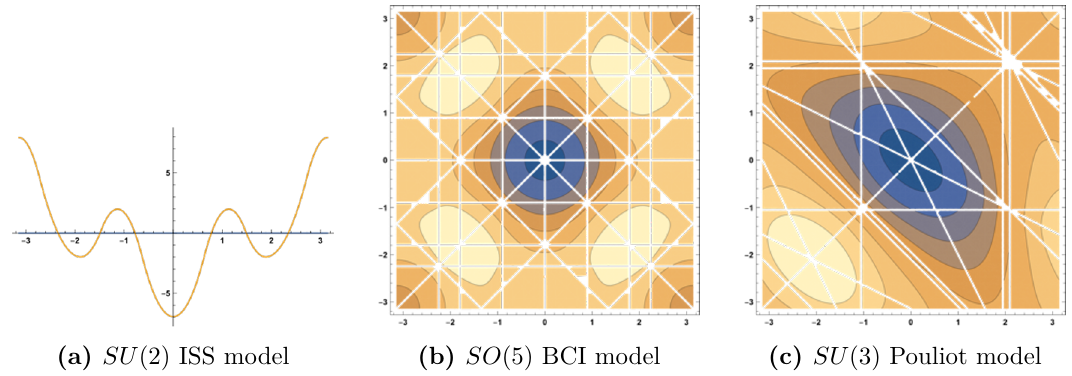
Figure 5. Im F| ∆= − iπ for SU (2) ISS model, SO (5) BCI model, and SU (3) Pouliot